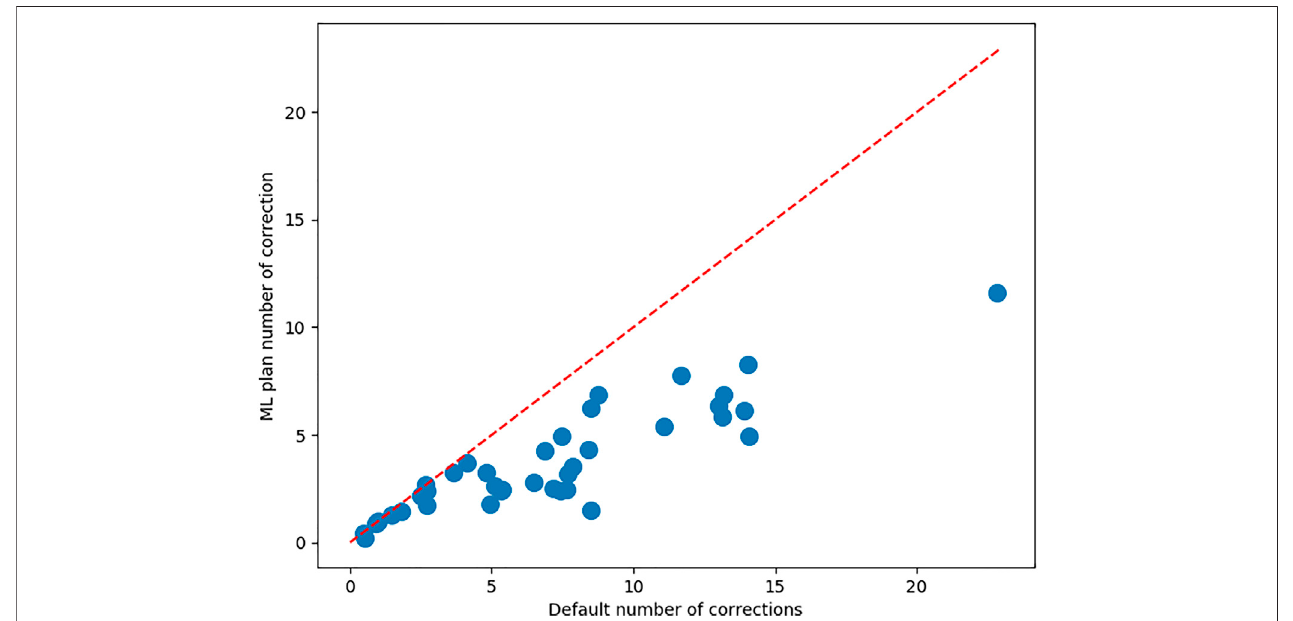
FIGURE5| Foreachofthesurgeons,theaveragenumberofcorrectionstobemadetotheMPPandthebestMLplan.Theredbisectorindicatesthelinewhereno improvement occurs upon the MPP.